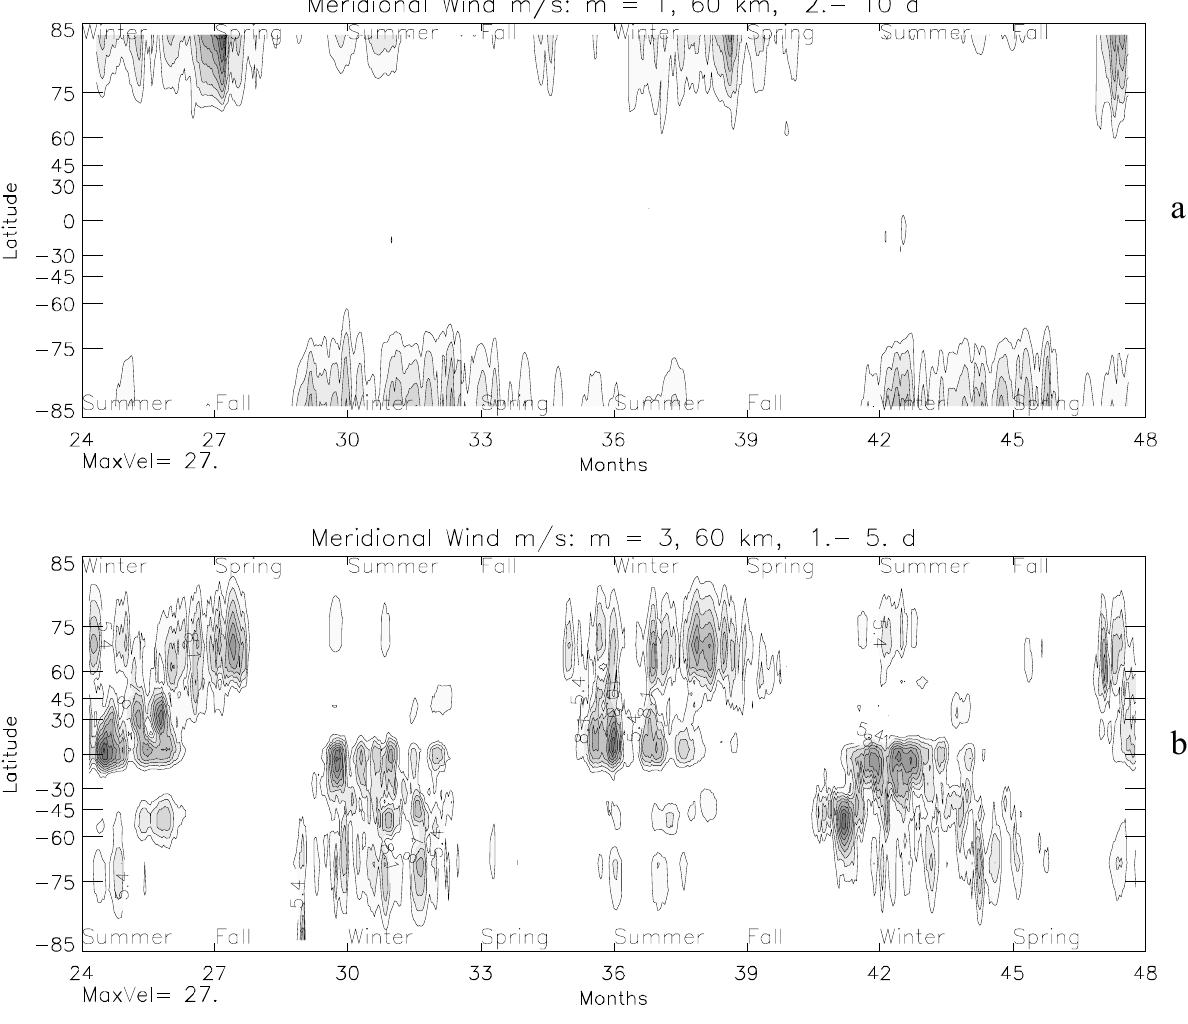
Fig. 11. Computed seasonal variations of meridional winds at 60km for planetary waves with zonal wave numbers m=1 and 3. The resemblance with the seasonal variations of the IGWs in Fig. 8 indicates that both classes of waves have similar roots as discussed in the main